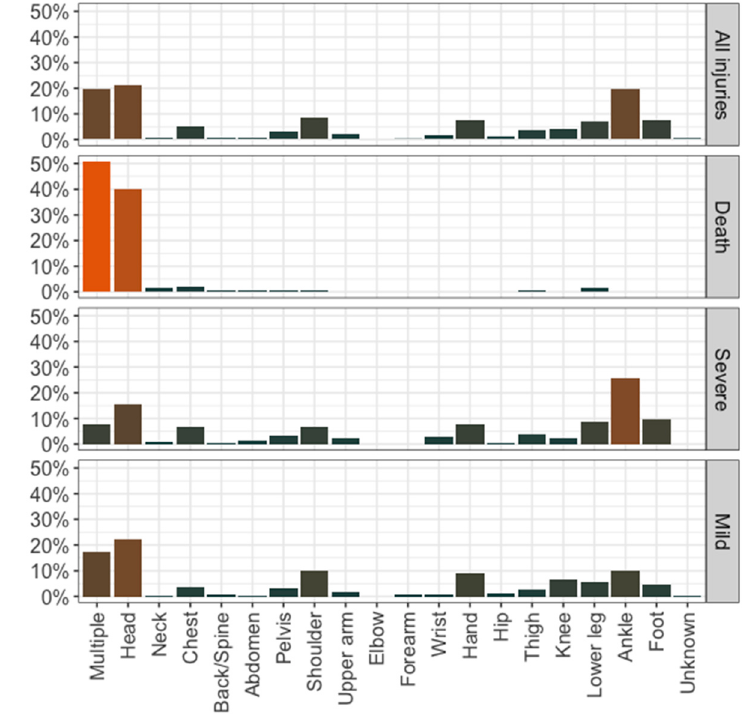
Figure 2. Injury localization depending on injury severity.